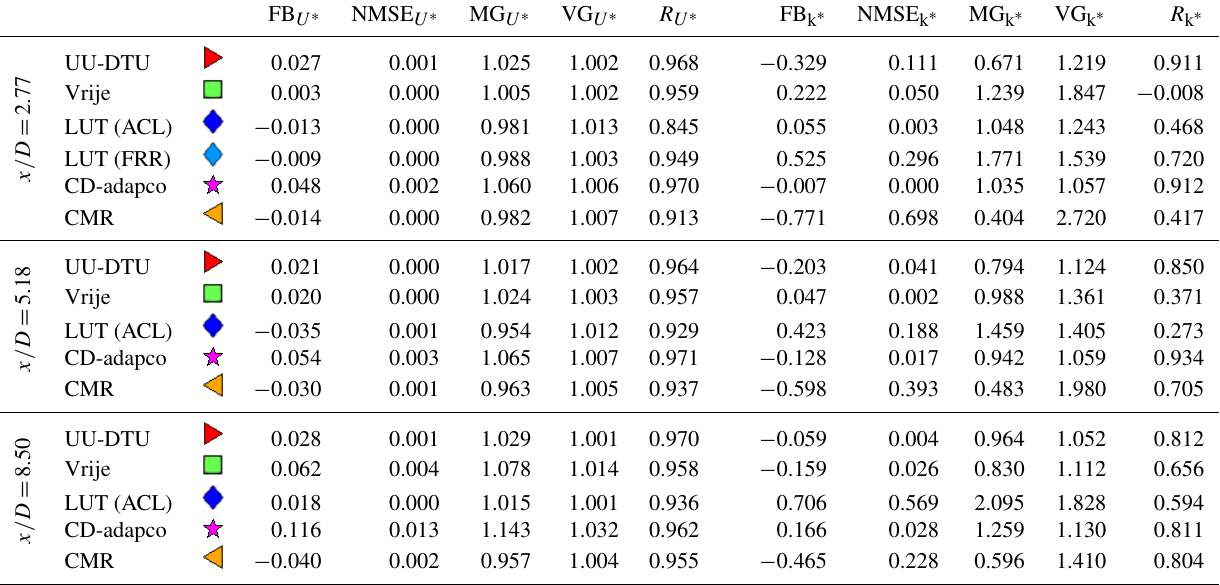
Table 6. Statistical performance measures FB, NMSE, MG, VG and R of the normalized mean velocity U ∗ and normalized turbulent kinetic energy k ∗ predictions of the five different models for test case B3. The wake flow is predicted at stream-wise measurement positions x/D = 2.77, 5.18 and 8.50 downstream of